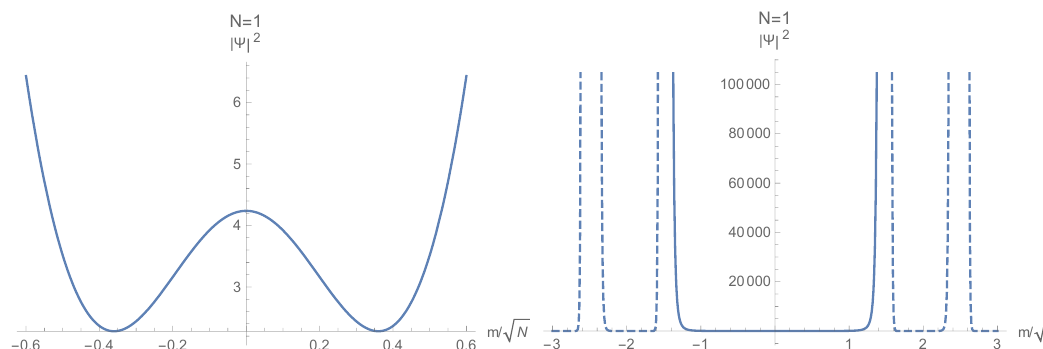
Figure 1 . For a deformation corresponding to turning on a bulk pseudoscalar (cid:12)eld, j (cid:9) 2 ( m ) j over a short and a long range at N = 1. The point m = 0 has been excluded from the short range plot due to problems with the numerical evaluation of very small numbers.